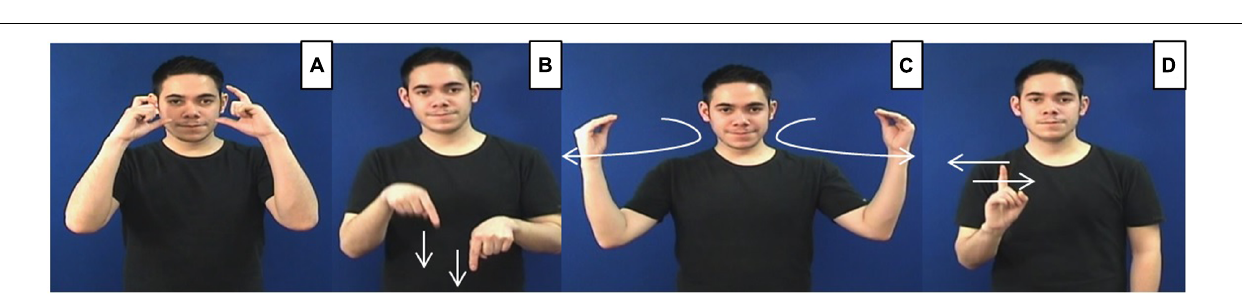
FIGURE 3 | British Sign Language (BSL) signs showing different degrees of meaning transparency. Transparent signs are the easiest to relate to their referent (e.g., A : CAMERA), followed by translucent (e.g., B : TO-LIMP), then obscure signs (e.g., C : HOLLAND), and the most difficult to associate with its concept are opaque signs (e.g., D :